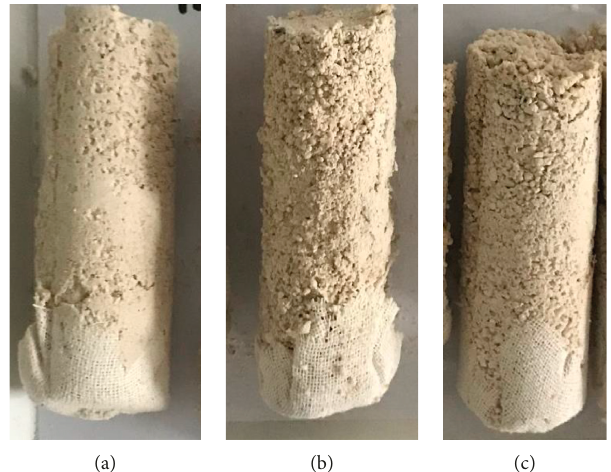
Figure 4: The soil column after the MICP process with different soil particle distributions: (a) soil #1; (b) soil #2; (c) soil #3.